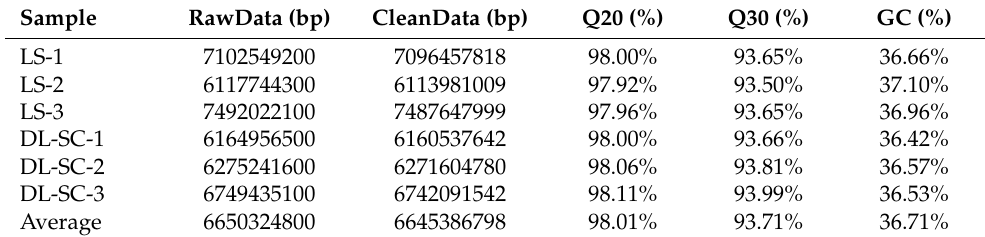
Table 3. Summary of the transcriptome data for the two P. citri